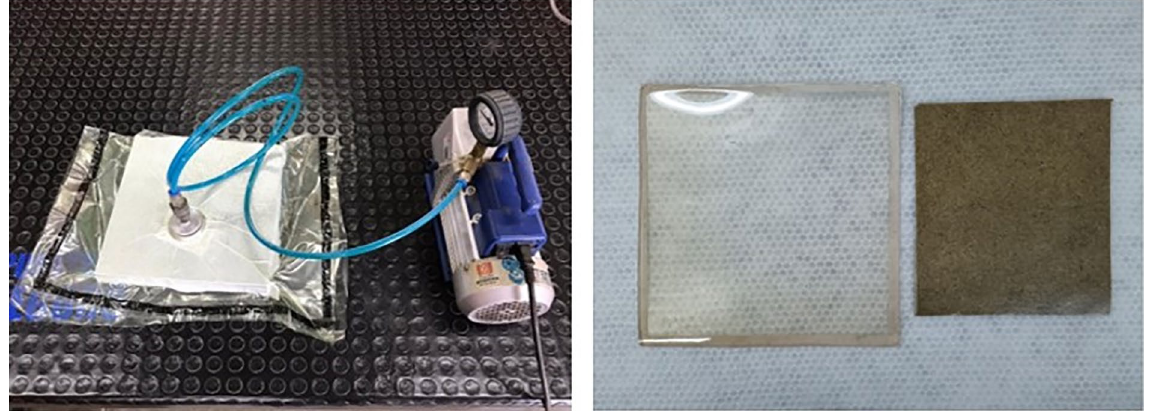
Figure 2. Resin film infusion process (left) and neat EP and EP-FP biocomposite sheets obtained with the resin film infusion process